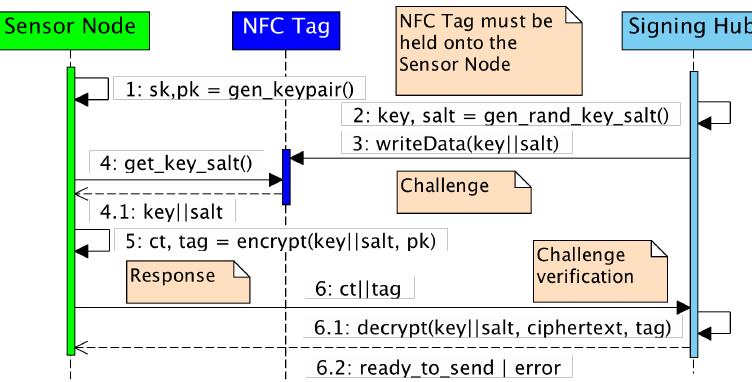
Figure 1. NFC-KE Phase 1: Fundamental public key exchange scheme